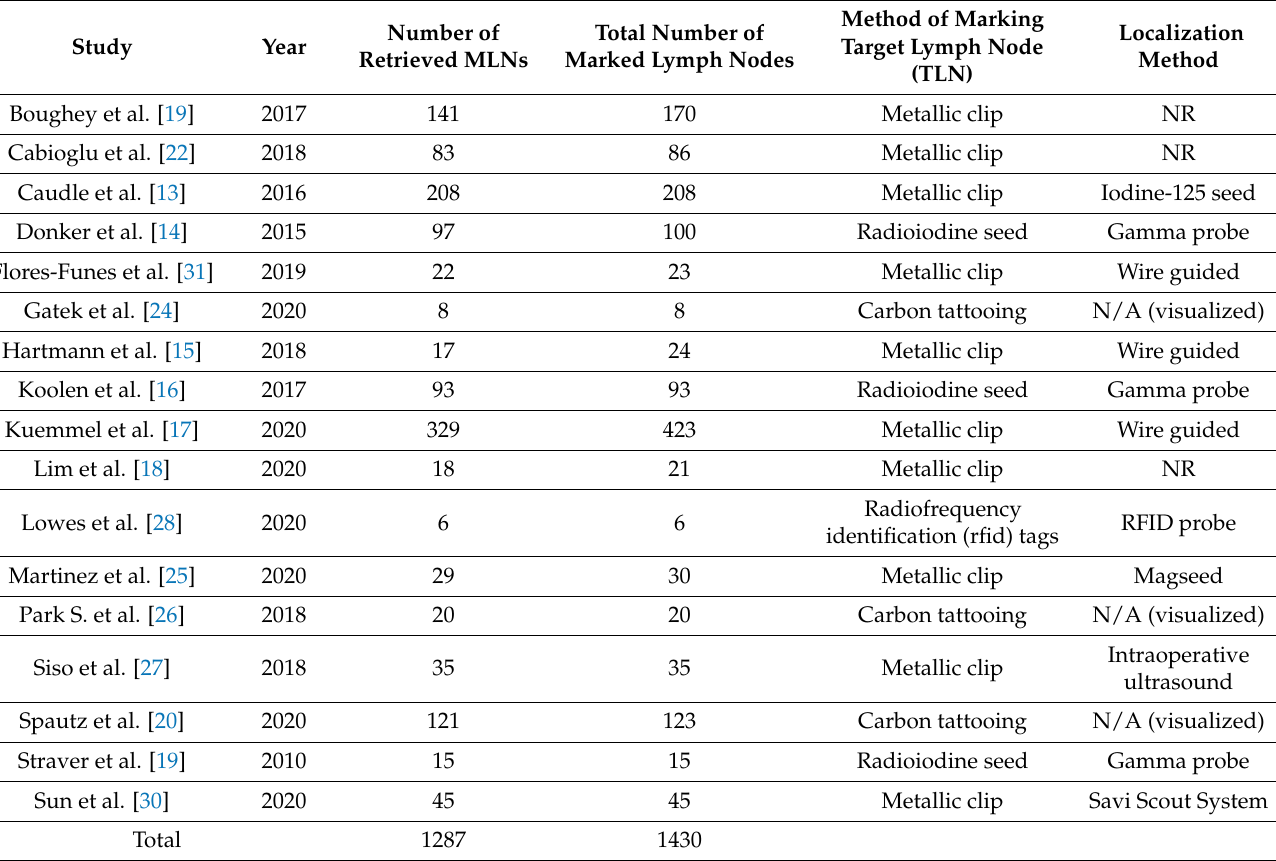
Table 3. Successful retrieval